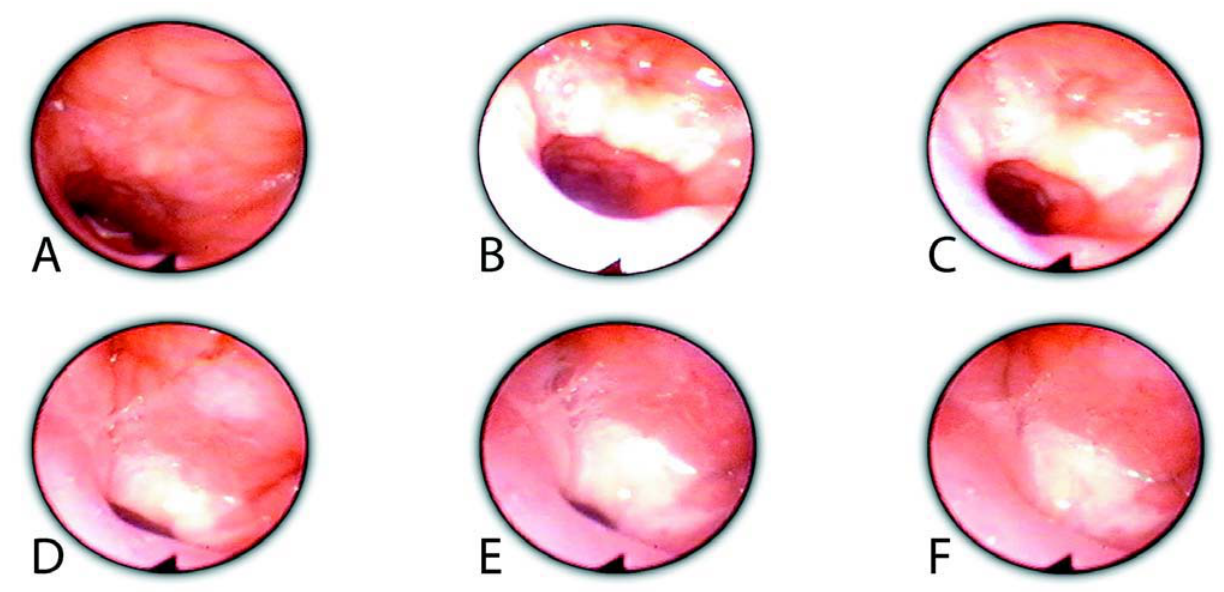
FIGURE 5- Nasoendoscopic images of the velopharynx for one participant before and during diagnostic therapy. A : At rest; B : Production of /pa/ before diagnostic therapy; C : Production of /pa/ at the beginning of diagnostic therapy; D & E : Production of /pa/ showing reduction in the size of the velopharyngeal gap as the diagnostic therapy progressed; F : Production of /pa/ showing elimination of velopharyngeal gap during diagnostic